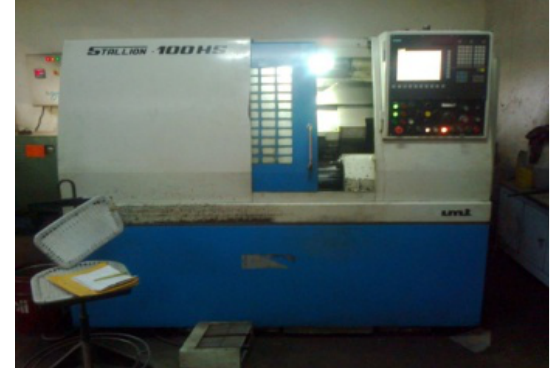
Fig. 3. A HMT CNC turning center STALLION 100HS